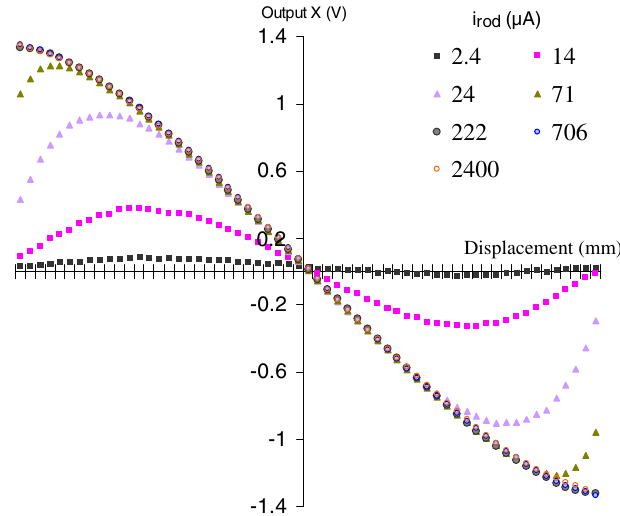
FIG. 17. (Color) X response of the BPM reading with the LR- BPM versus the rod displacement. The values of the current take into account the correction with (cid:1) (Sec. II A). For a current above 10 (cid:2) A AC, the nonlinearities are acceptable and the beam can be centered by iteration with a precision of 100 (cid:2) m variation; at lower beam currents ( < 100 (cid:2) A ) we observe substantial nonlinearities (drop of gain).